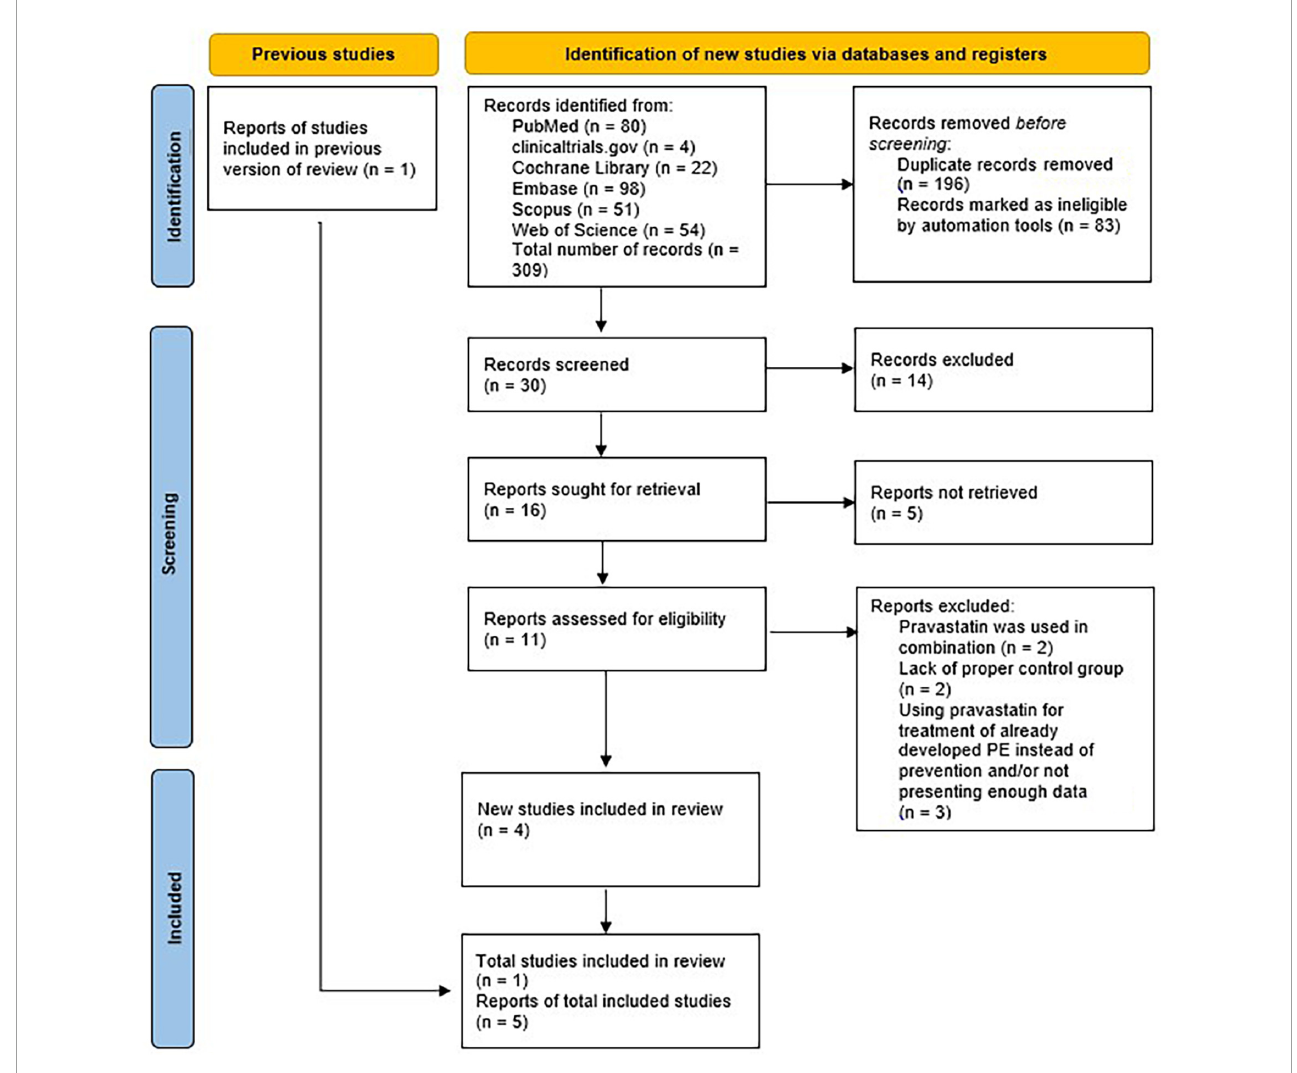
FIGURE2 Meta-analysis flow diagram of